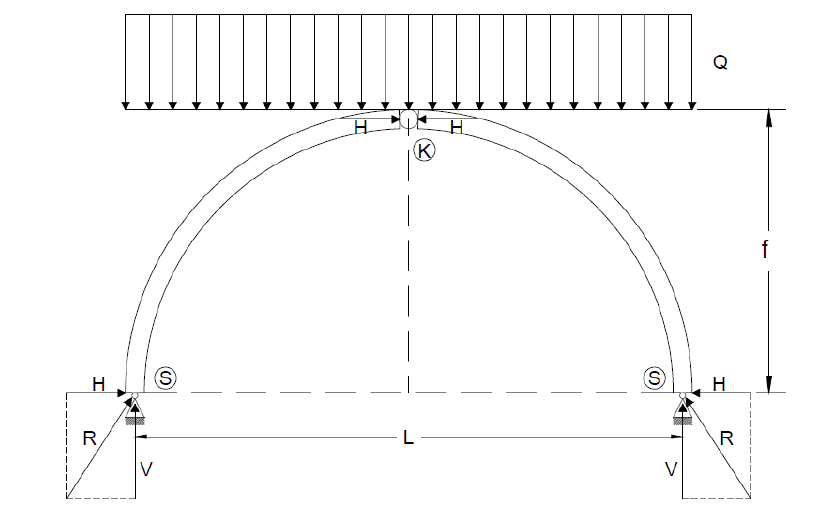
Figure 13. Tri-articulated isostatic arch. Graphical sketch of tri-articulated isostatic arch. (S= salmer, support stone; K= keystone; L= light of the arch; H= horizontal reaction; V=vertical reaction; R= Resulting reaction; Q= linear distributed load; f= deflection of the